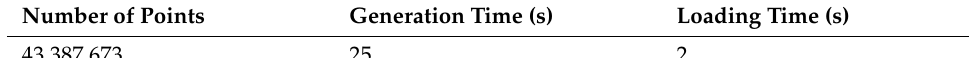
Table 8. Point cloud visualization with Potree: Generation and loading times.